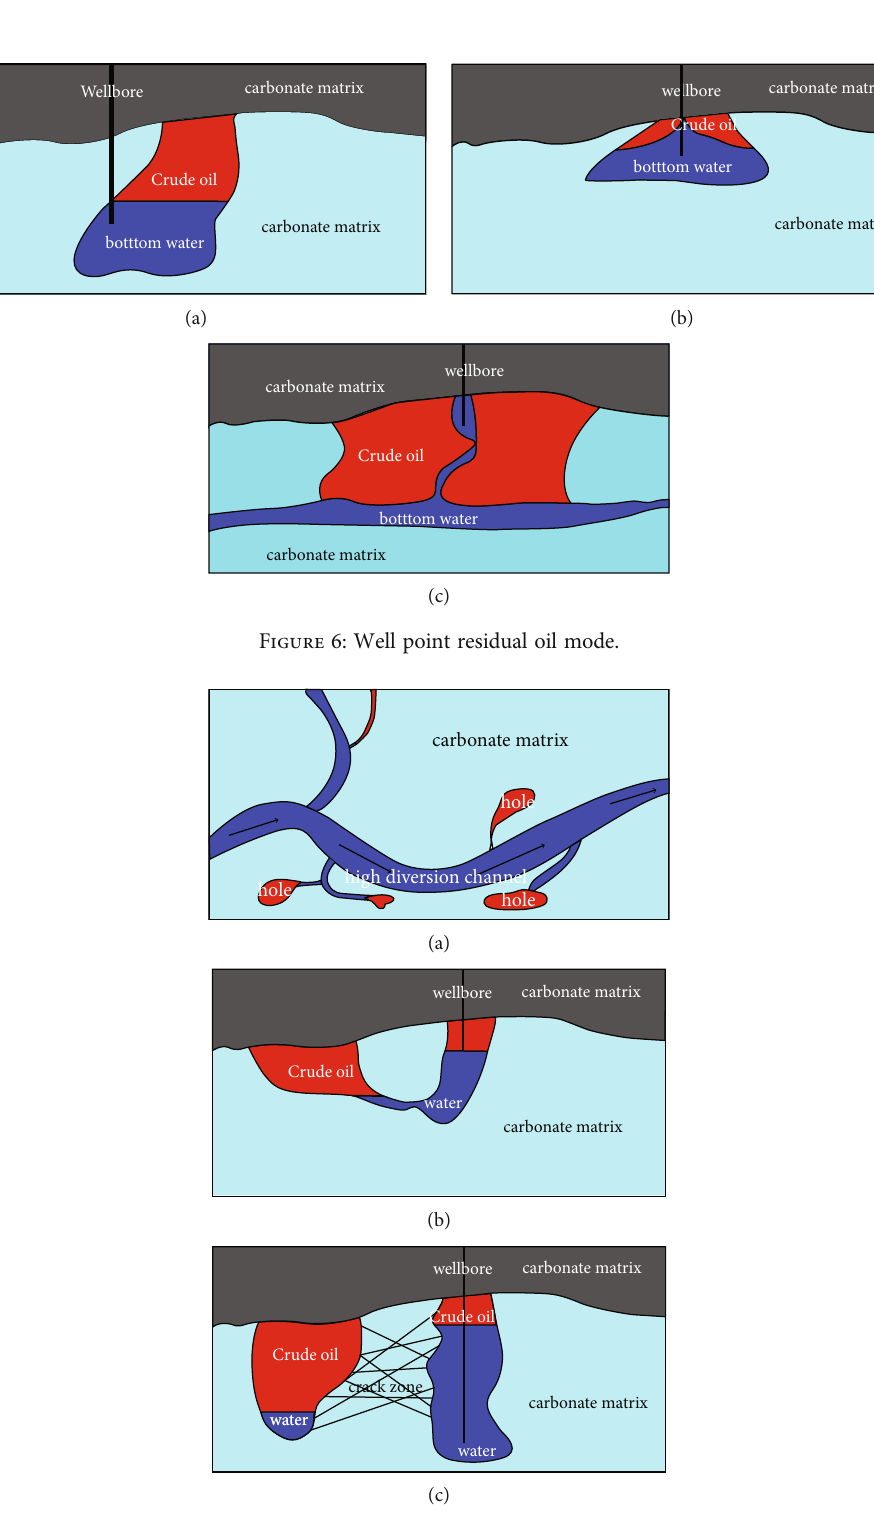
Figure 7: Residual oil pattern between